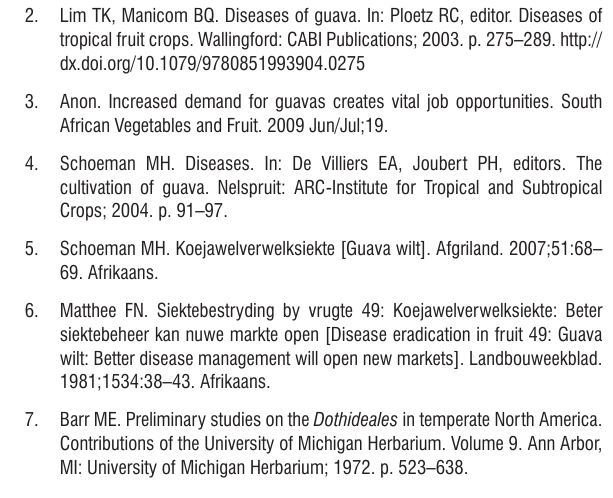
Table 2: Species included in the phylogenetic analyses Species